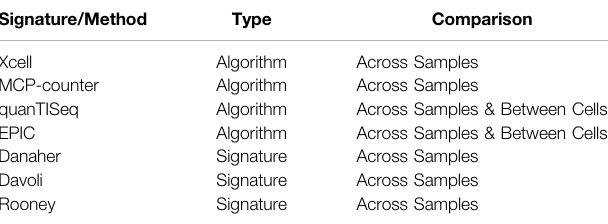
TABLE 1 | Default deconvolution method and signatures included in